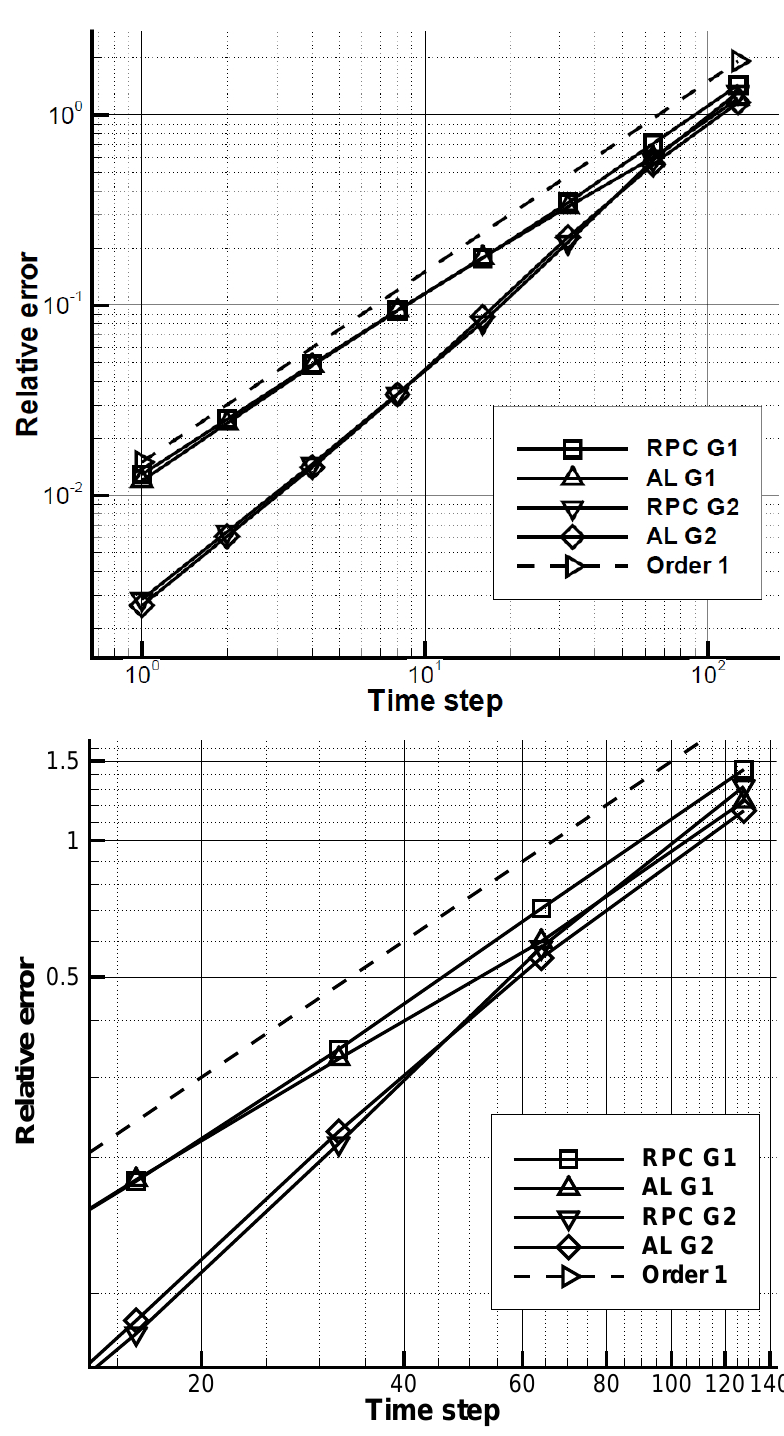
Figure 8. Evolution of the temporal error for the period of oscillation for the flow past a cylinder at Re =